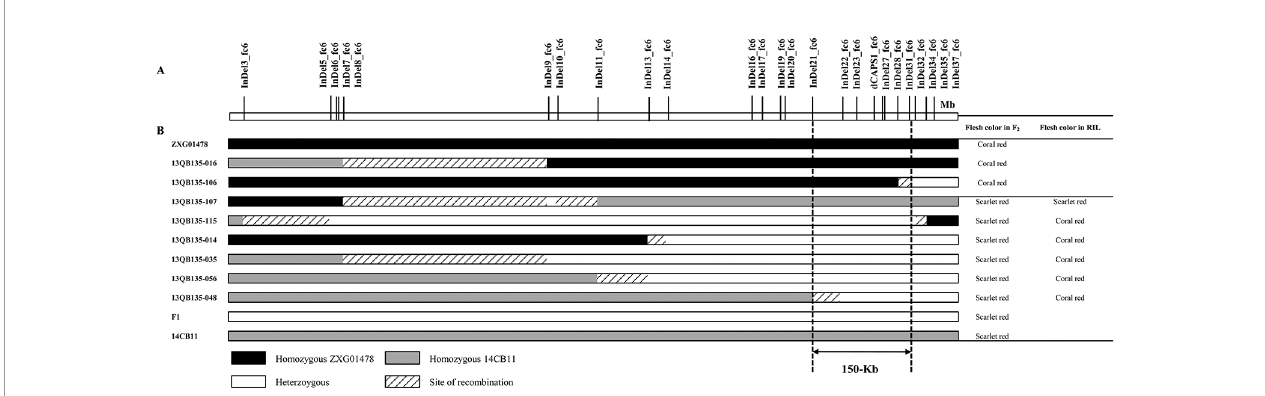
FIGURE 3 | Graphical genotype of the recombinants in F 2 and their fl esh color in the F 2 and recombinant inbred line (RIL) populations. (A) Partial physical map of the genomic region of Y scr on chromosome 6. (B) Y scr was narrowed to a 150 Kb region between InDel21_fc6 and InDel31_fc6 by analyzing the genotypes and phenotypes of the eight